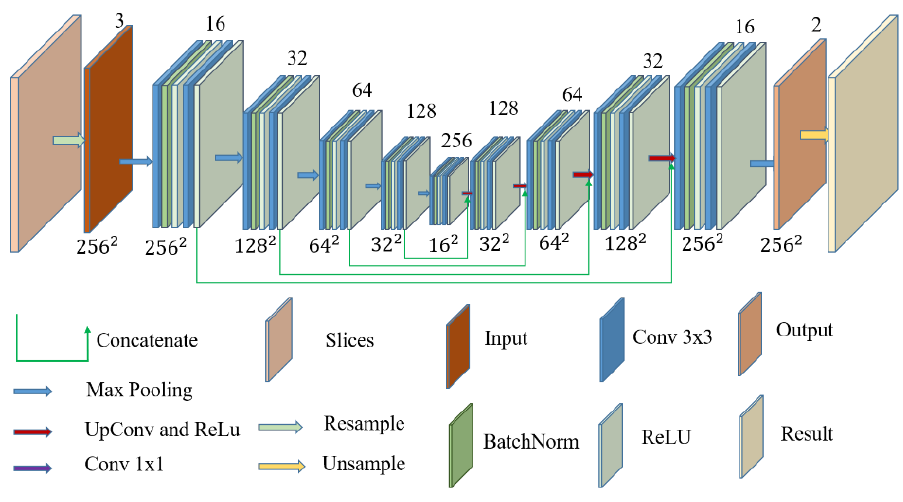
Figure 4. U-Net network